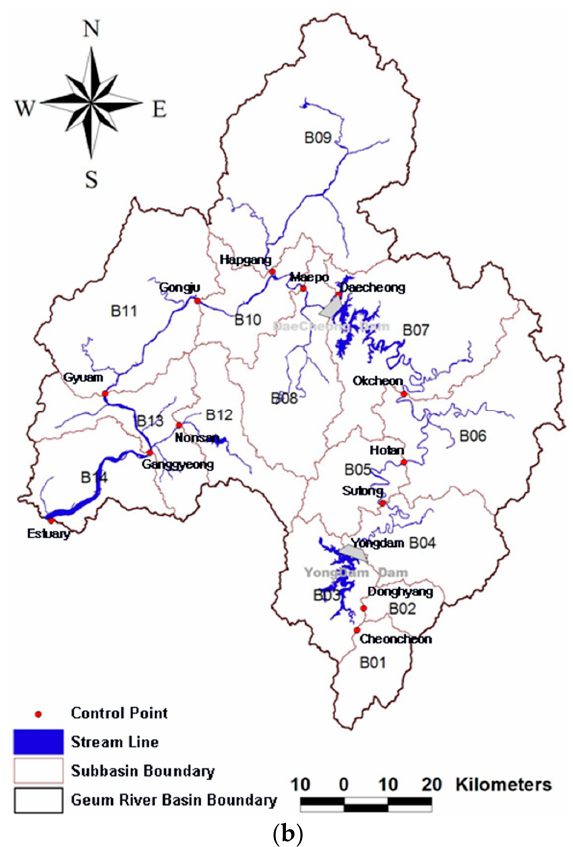
Figure 1. Overview of the studied watershed: ( a ) water supply system; and ( b ) sub-basin and main control points.